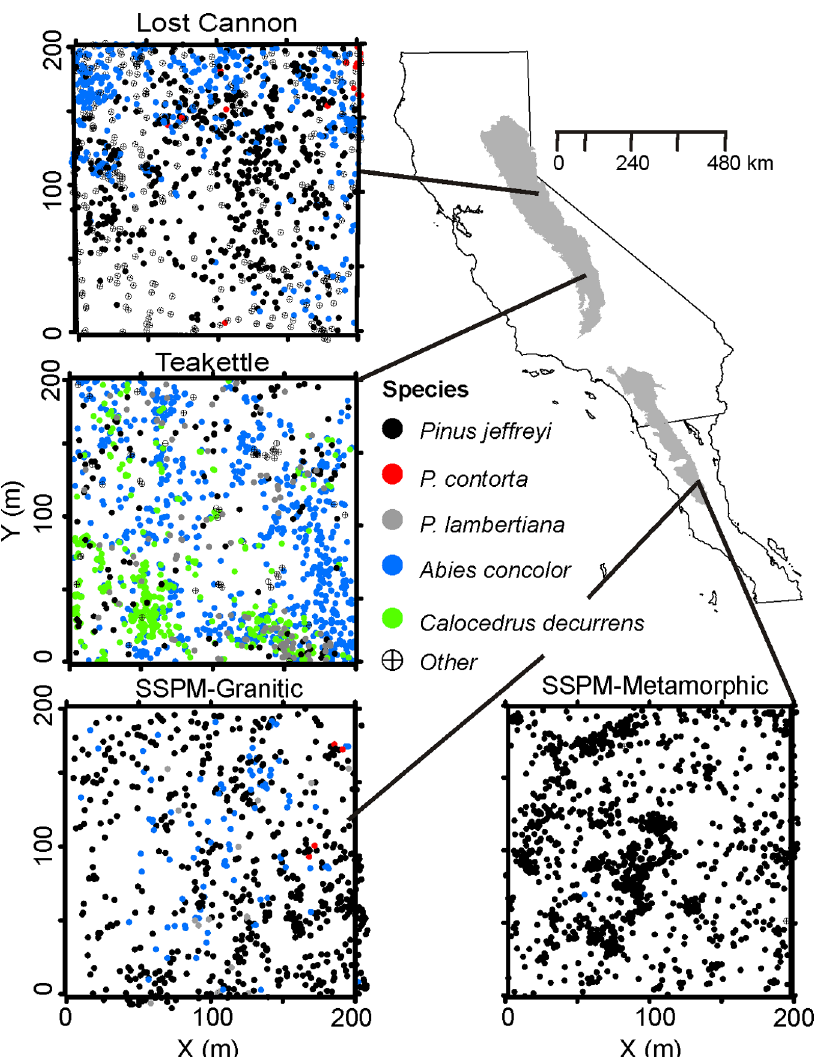
Figure 1. Study sites and live tree (diameters . 5 cm) locations in old-growth Jeffrey pine-mixed conifer forests in the Sierra Nevada (upper shaded area), eastern California, and the southern Peninsular Range (lower shaded area), northwestern Mexico. Species identified as other include Juniperus occidentalis , Abies magnifica , Populus tremuloides , Prunus emarginata , Quercus kelloggii , and Q. chrysolepis .